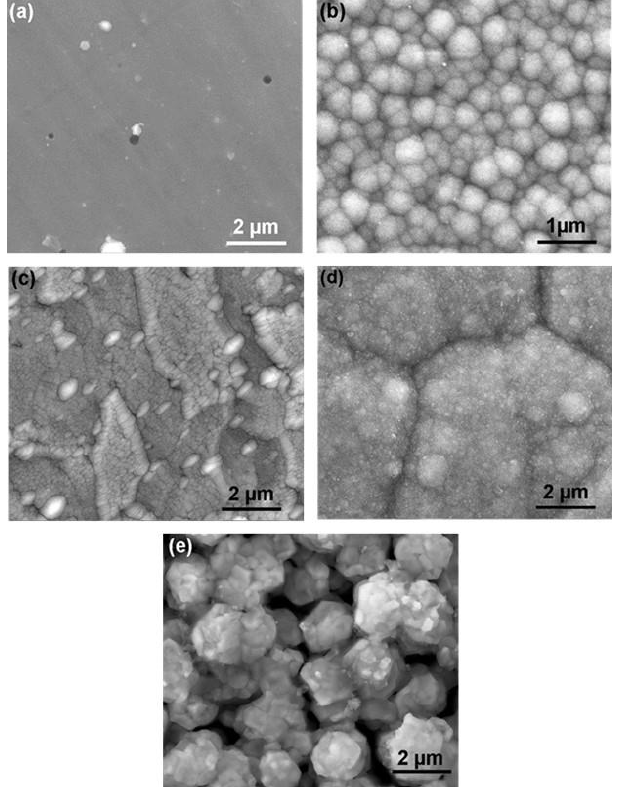
Figure 4. SEM images showing the microstructure of the coatings in detail ( a ) AlTiN ( b ) DLC ( c ) TiAlN/VN ( d ) TiBCN ( e ) TiB 2 .